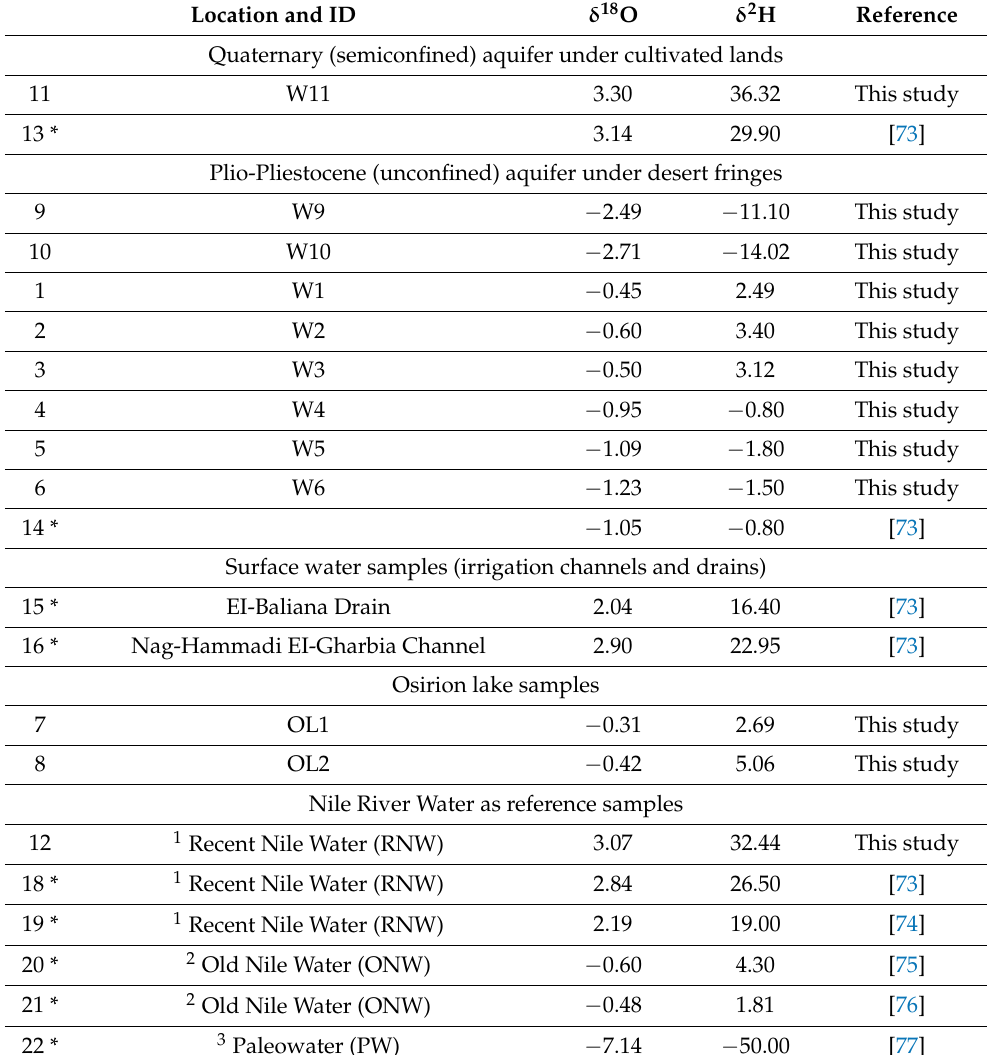
Table 1. Overview of data used for isotope study in the investigated area. Both δ 18 O and δ 2 H values are expressed in part per mil (‰). Location and ID